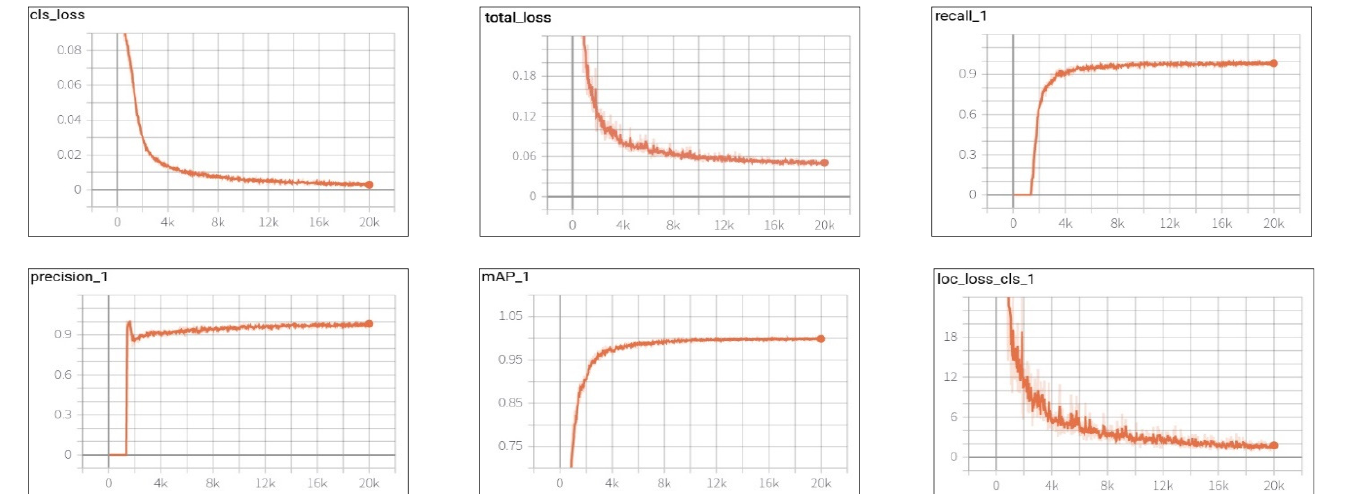
Figure 7. Loss graphs obtained from the improved point-GNN learning.